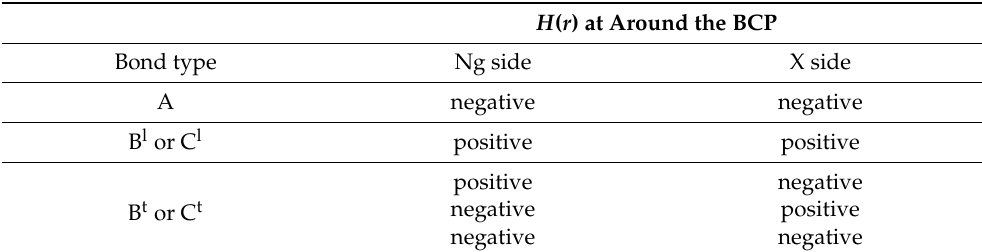
Table 1. Criteria to assign the Ng-X bonds of type A, B, or C in terms of the sign of the H ( r ) at around the